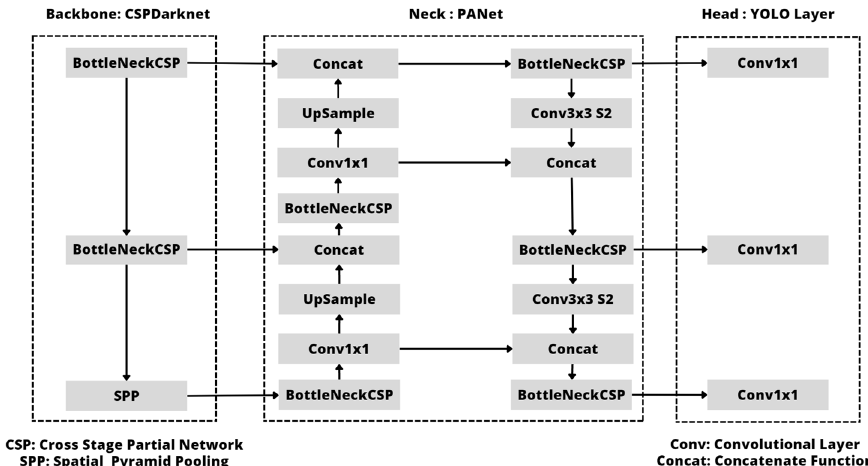
Figure 1. YOLOv5